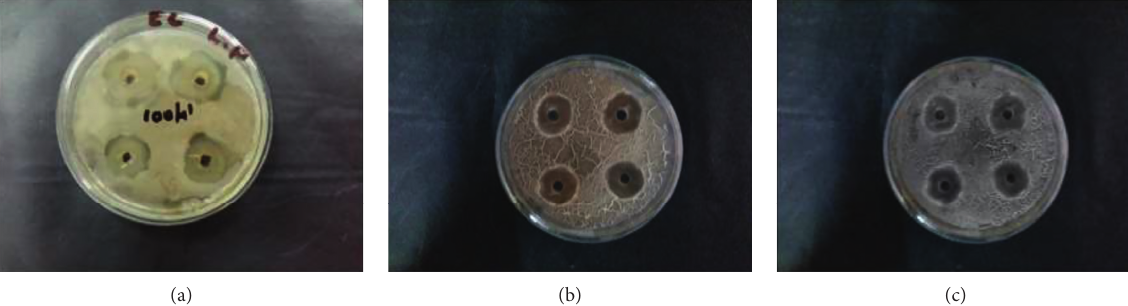
Figure 5: Antibacterial activity of silver nanoparticles synthesised using (a) lemon peel, (b) orange peel, and (c) green orange peel extract against Escherichia coli